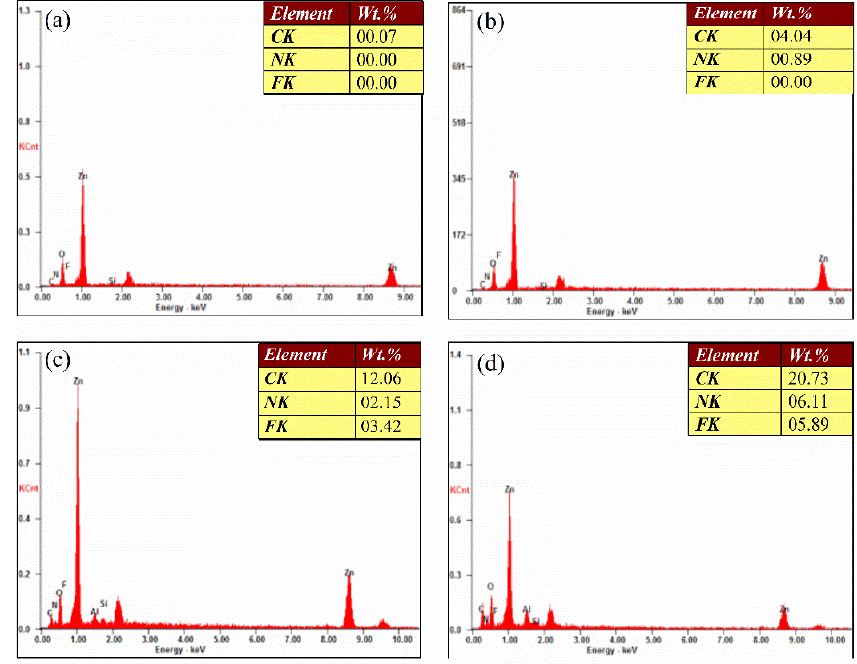
Figure 4. EDS energy spectrum analysis. ( a ) ZnO; ( b ) ZnO − APTES; ( c ) ZnO − APTES − F; ( d ) ZnO − APTES − TRF.